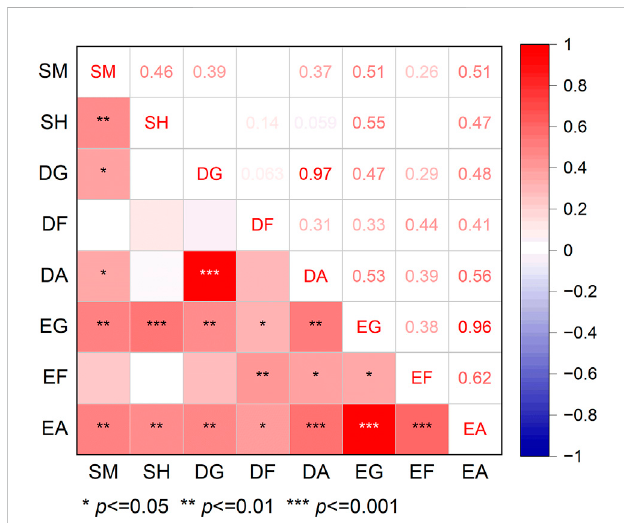
FIGURE 4 Pearson ’ s correlation coef fi cients between soil moisture and seedling emergence. SM, mean soil moisture; SH, soil hardness; DG, seedling density of grasses; DF, seedling density of forbs; DA, seedling density of all annuals; EG, total seedling emergence of grasses; EF, total seedling emergence of forbs; EA, total seedling emergence of all annuals.